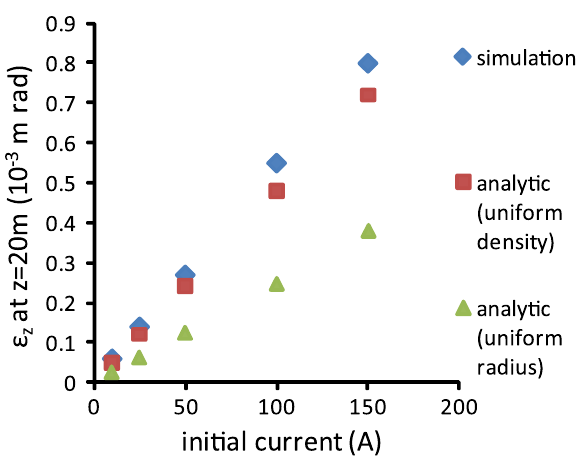
FIG. 19. z emittance at z ¼ 20 m ( (cid:1) 10 (cid:2) 3 ) vs initial tilt, showing 2 cases with uniform beam radius (green), uniform charge density (red), and WARP simulation